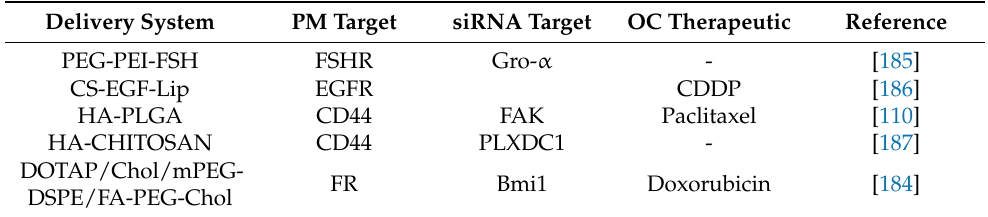
Table 1. Select target delivery systems against